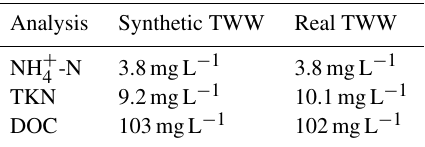
Table 2. Chemical composition of the synthetic WW and the real WW after